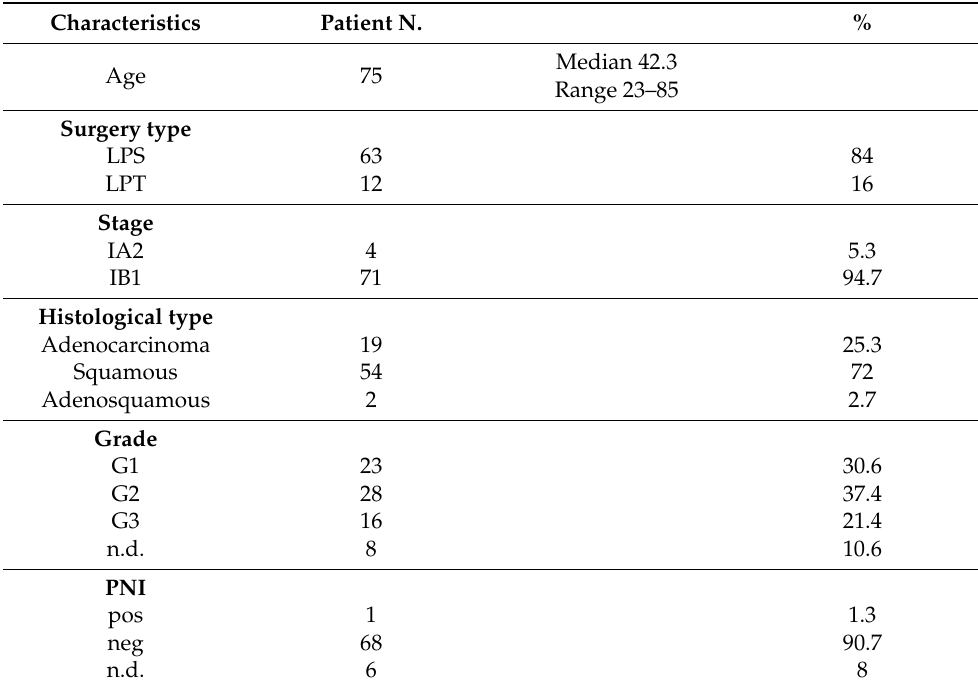
Table 1. Patients’